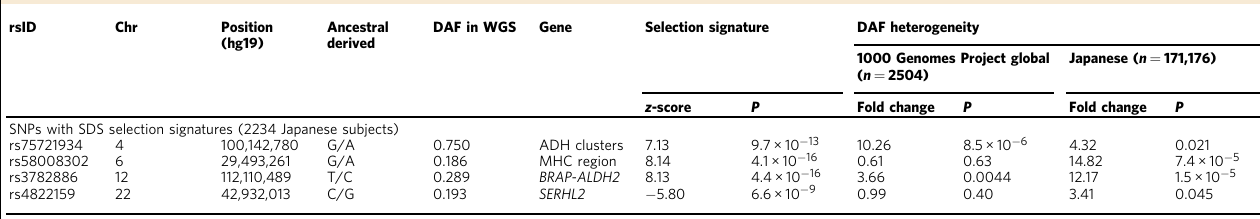
Table 1 SNPs with very recent natural selection signatures in the Japanese population rsID Chr Position Ancestral DAF in WGS Gene Selection (hg19) derived